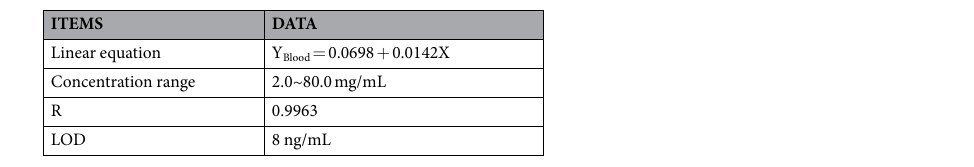
Table 2. Calibration equations and LOD of Alcohol in samples (n = 6). Y stands for the peaks area ratio of alcohol and isopropanol; X stands for concentration of alcohol (mg/mL).